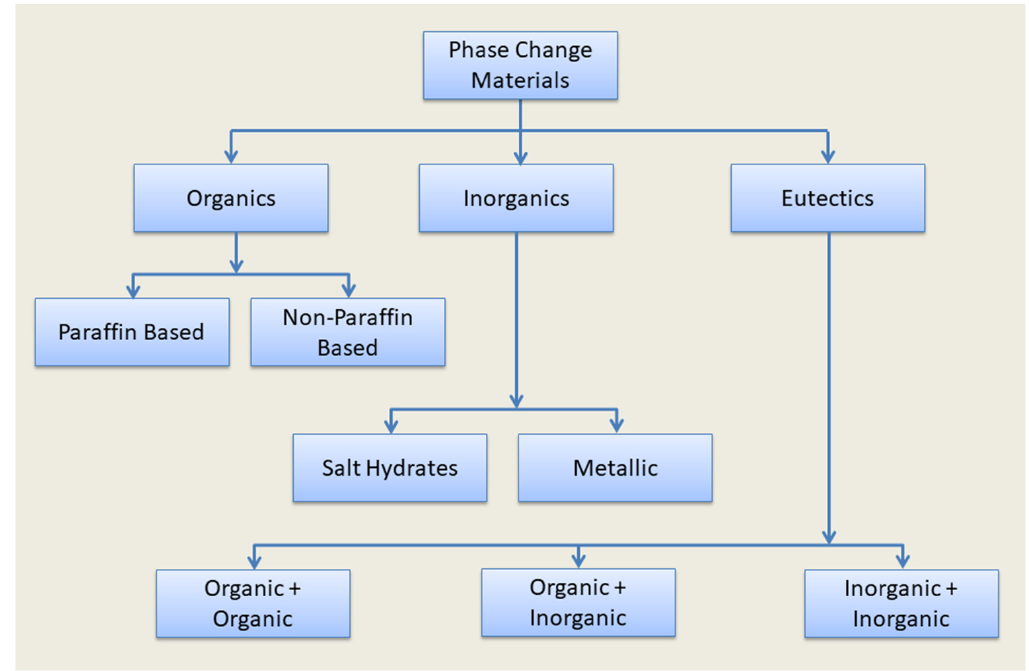
Figure 1. The broad classification of PCMs.